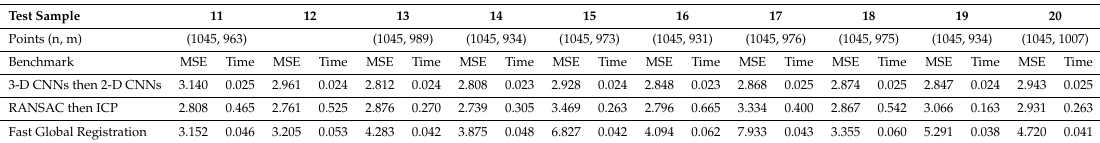
Table 8. The comparisons about MSE and computation time of “Buddha” data for test samples from 11 to